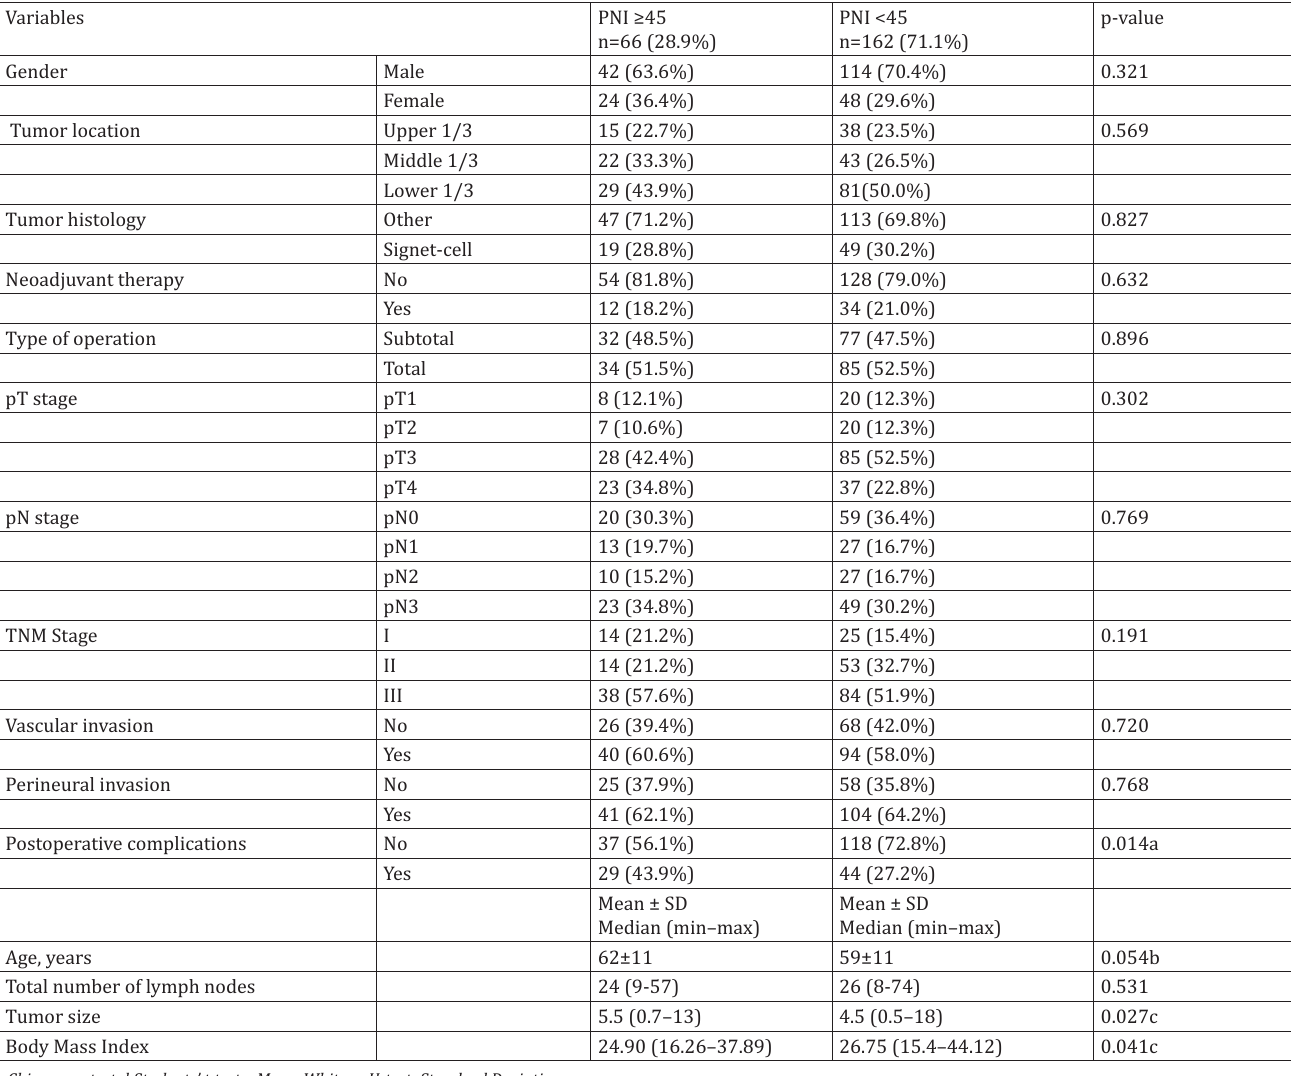
Demographic and clinicopathological characteristics of patients divided into two groups depending on PNI cutoff value